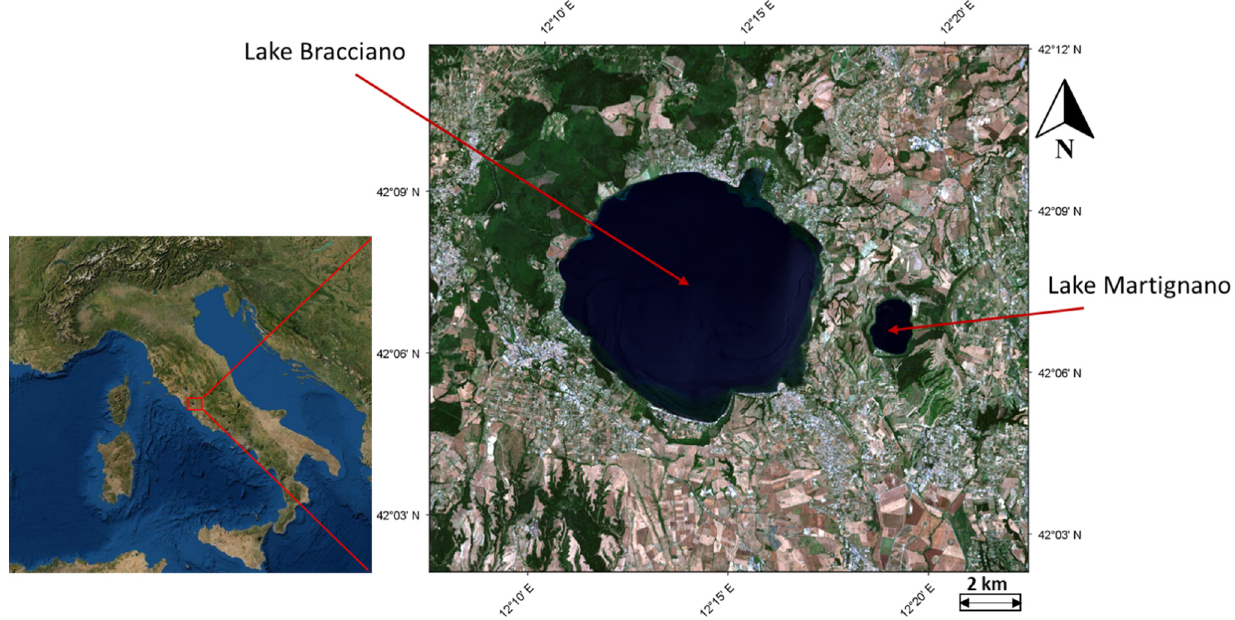
Figure 1 . The Lakes of Bracciano and Martignano, natural RGB composite from Sentinel-2 L2A product acquired on 30 June 2019.